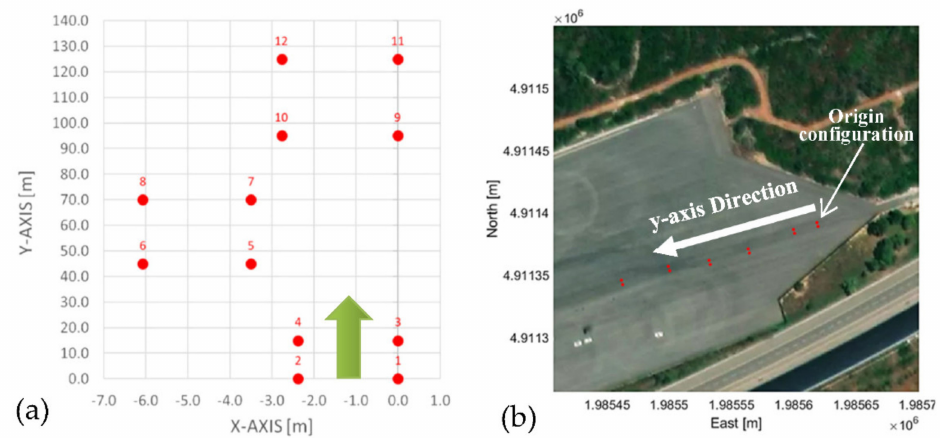
Figure 19. Point configuration defined by the ISO 3888-1 standard arranged in a Cartesian reference system ( a ); point arrangement of ISO 3888-1 vehicle test on the satellite map of the Mapbox tool ( b